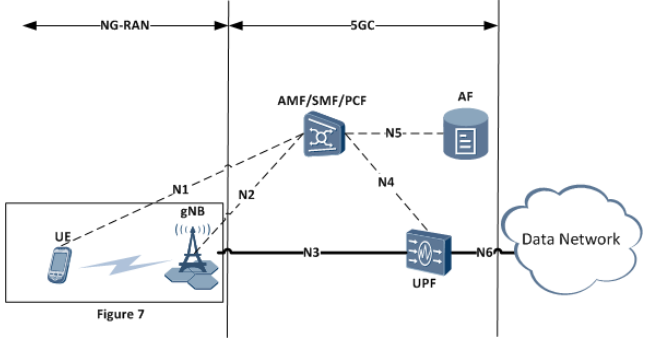
Figure 6. 5G NR System